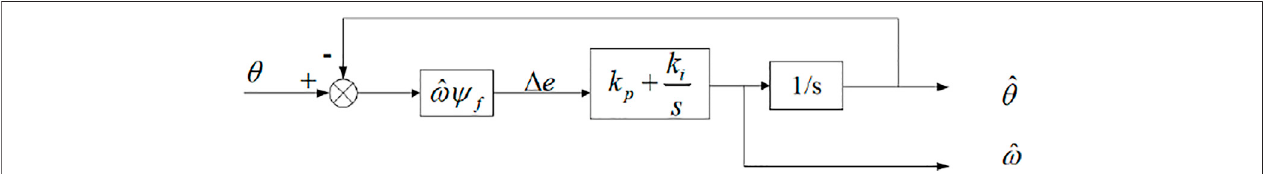
FIGURE 5 | Equivalent diagram of PLL control.